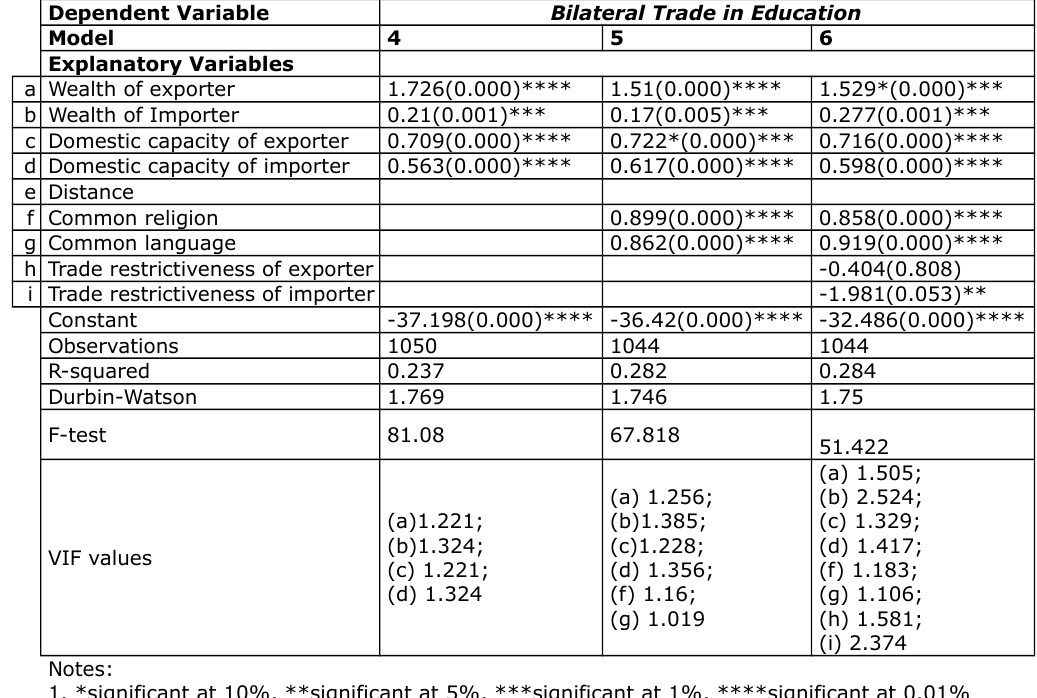
Journal of Industrial Engineering and Management, 2014